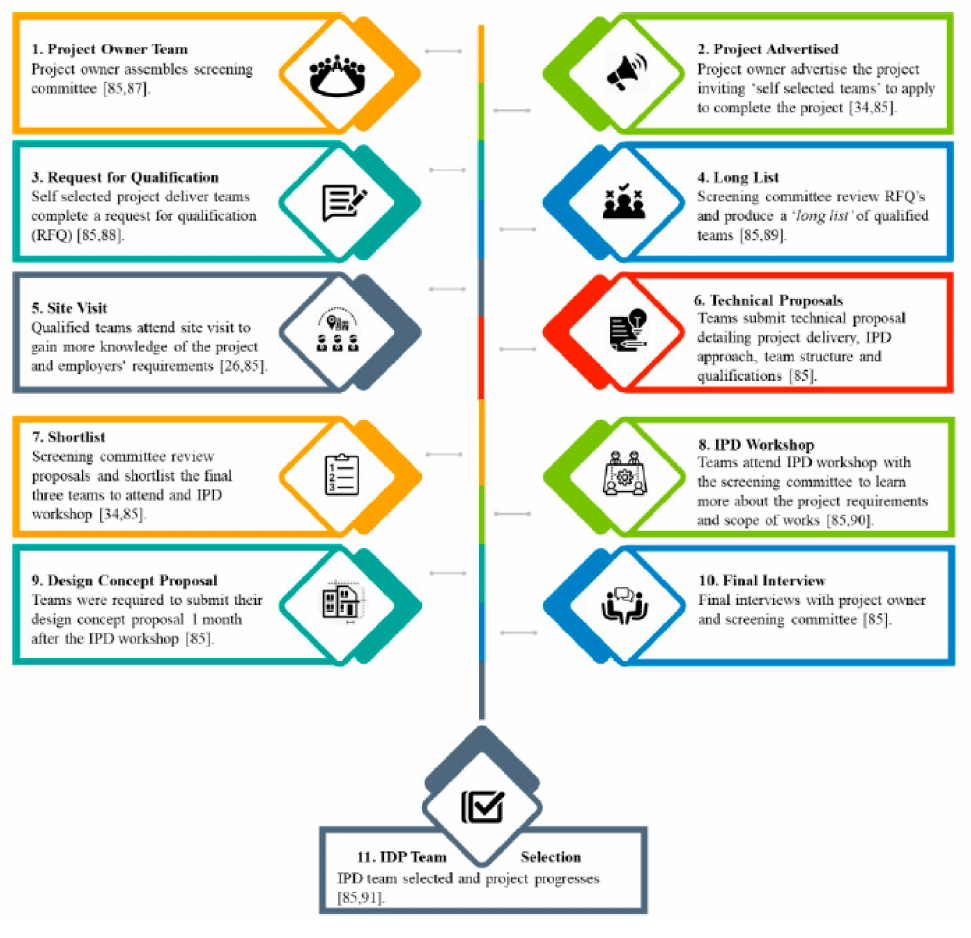
Figure 3. Integrated project delivery (IPD) selection process [26,34,85,87–91].